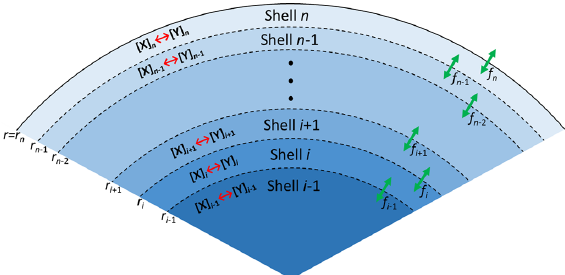
Figure 5. Schematic illustration of the PRAD model showing the shells, transport fluxes (green arrows), and chemical processes (red arrows) of each species. The particle is radially symmetric with the surface of the particle marked as r n